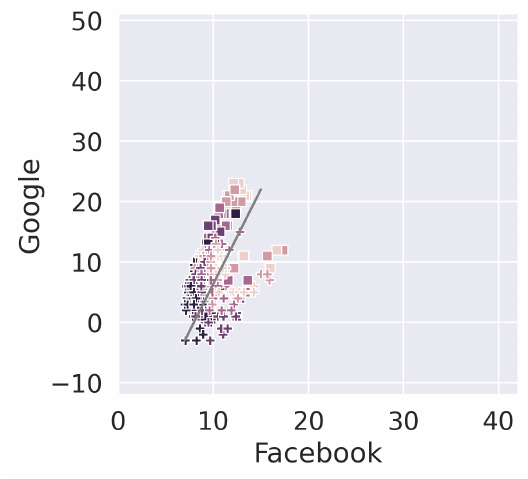
Figure 8. Mobility from 25 March to 27 June, using the same scale of Figure 6. The data of this figure is zoomed in and split between working days and weekend days in Figure